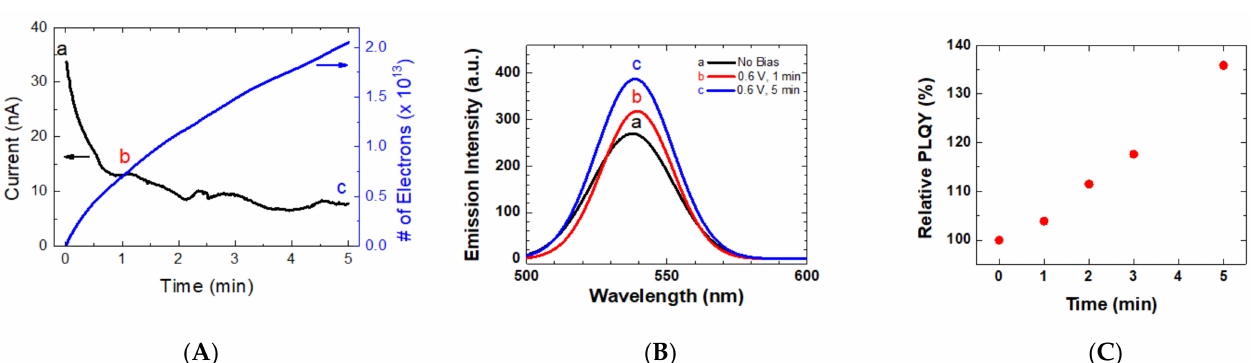
Figure 5. In situ photoluminescence spectra measurements under constant applied bias (+ 0.6 V) for electrodeposition of bromide on CsPbBr 3 perovskite film. ( A ) Current-time profiles and accumulated electron flow with time. ( B ) photolumines- cence spectra of the CsPbBr3 perovskite film during the moment assigned in ( A ). ( C ) Relative PLQY enhancement with comparison of (emission peak area at time)/(emission peak area at time zero without applied